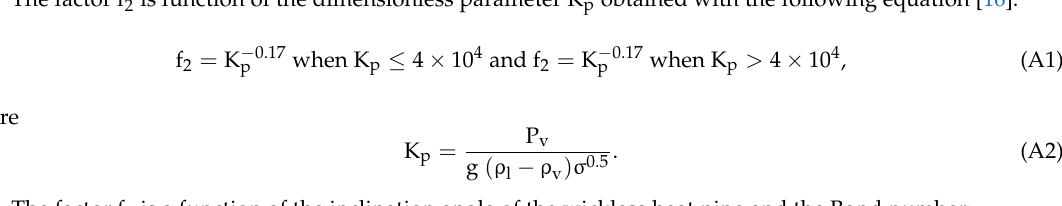
Figure A2. Variation of factor f 3 with the inclination angle β and the Bond number [27,28]. The Bond number for the mini-channel port can be expressed as follows: Bo = g (ρ l −ρ v )b 2 σ .